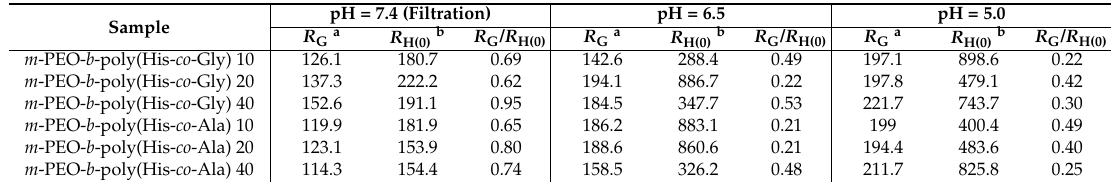
Table 3. R G / R H ratio from SLS/DLS measurements for samples of the synthesized polymers at 25 ◦ C. Sample